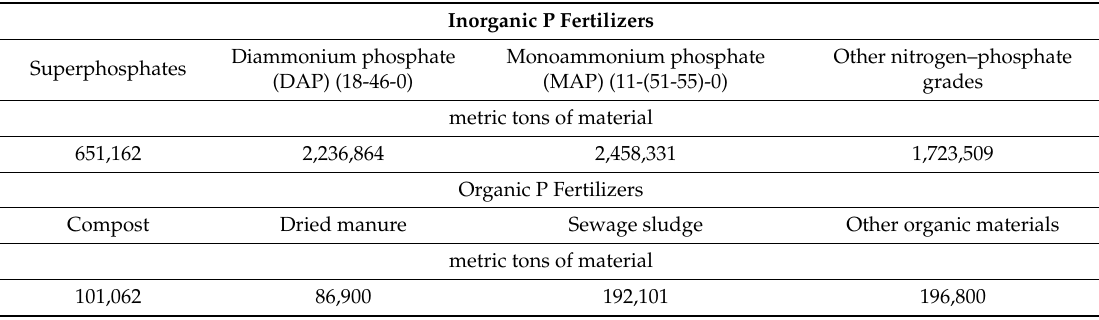
Table 1. Types and annual usage of phosphate fertilizers in the USA (the year 2015). Data are from the United States Department of Agriculture Economic Research Service (https: // www.ers.usda.gov / data- products /